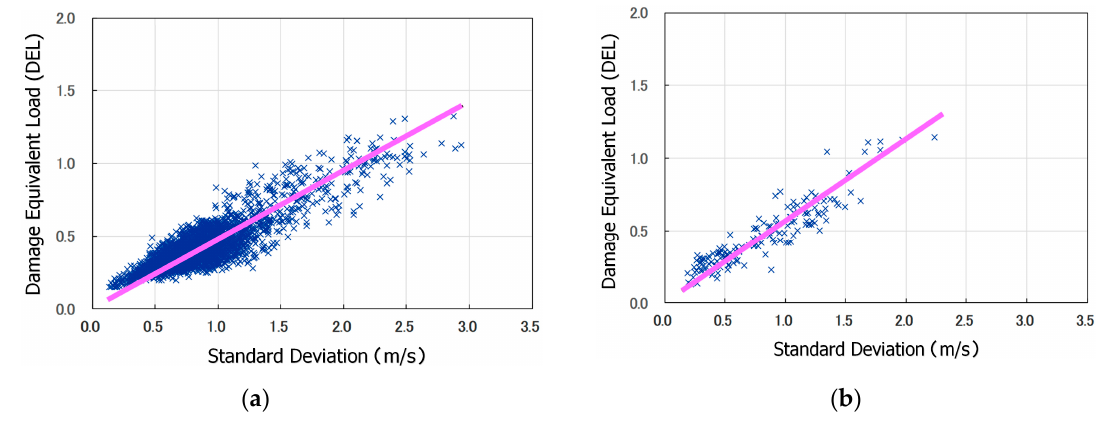
Figure 26. Relationship between standard deviation (m/s) and damage equivalent load (DEL). ( a )